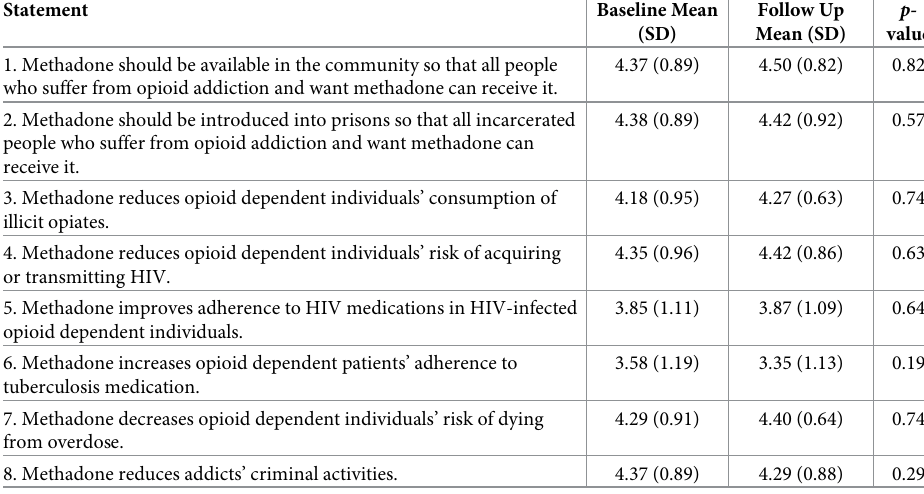
Table 4. Mean methadone attitude and knowledge scores at baseline vs. 1-month follow